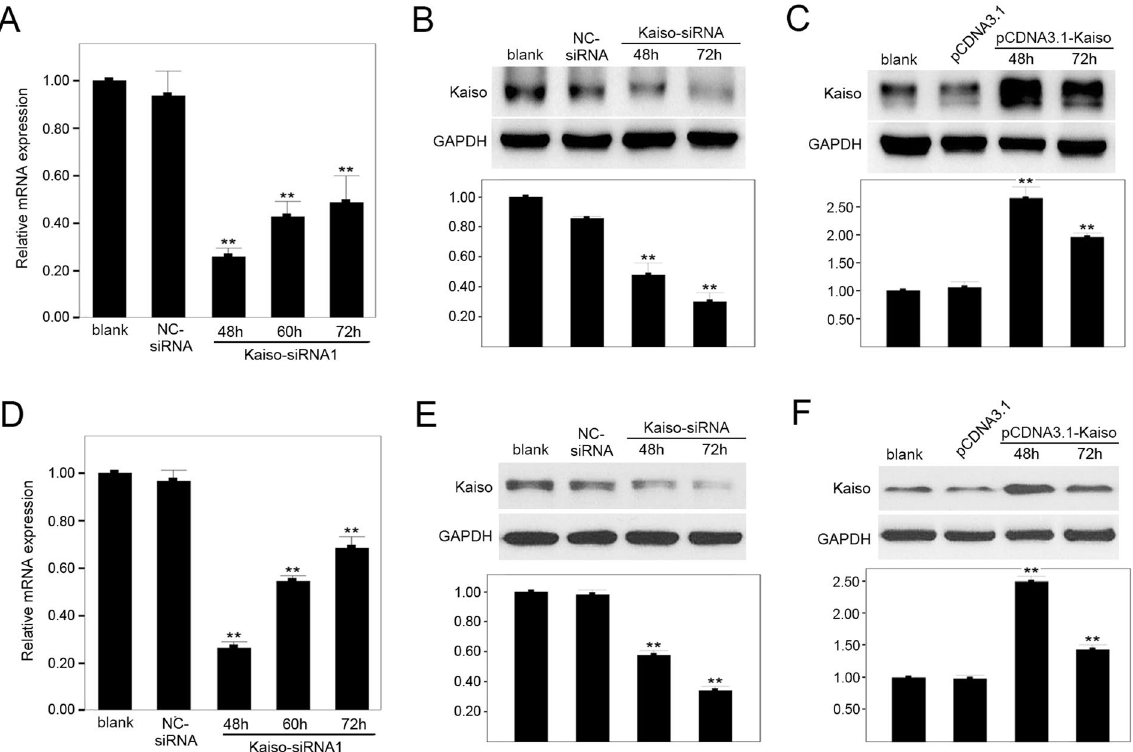
Figure 2. Selective silencing and overexpression of Kaiso in endothelial cells. HUVECs ( A , B ) and HMEC-1s ( D , E ) were transfected with NC-siRNA or Kaiso-siRNA1 and silencing efficiency was evaluated by quantitative real-time PCR ( A and D ) and Western blot ( B and E ) at 48, 60 or 72 h post transfection. HUVECs ( C ) and HMEC-1s ( F ) were transfected with pCDNA3.1 or pCDNA3.1-Kaiso and Kaiso expression was evaluated by Western blot at 48 and 72 h after transfection. GAPDH served as a loading control. Values are presented as mean ± SD, ** p < 0.01, compared with blank, n =